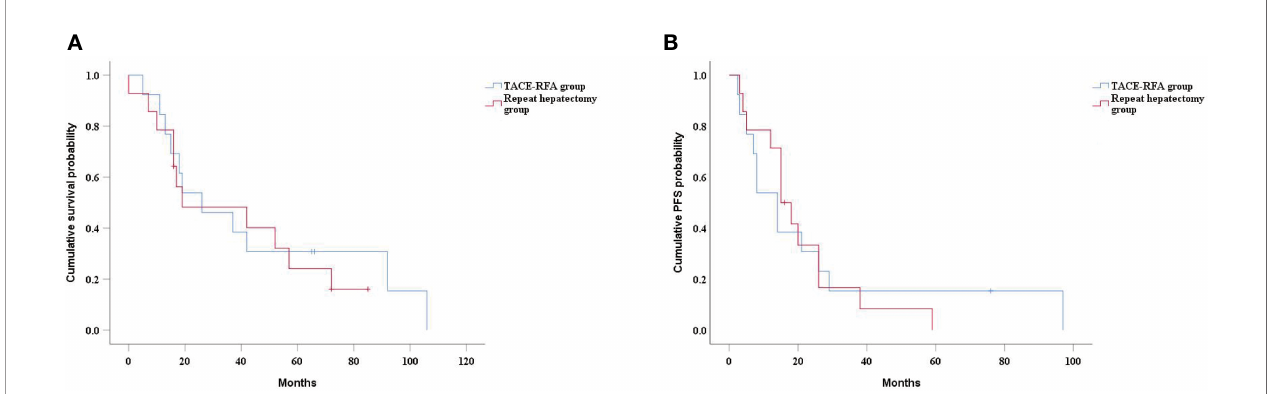
FIGURE 5 | Kaplan-Meier curves of cumulative survival (A) and PFS (B) in in patients with tumors larger than 5cm in diameter.